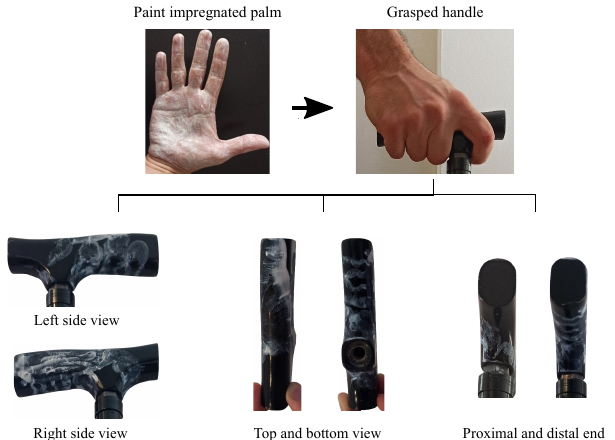
Figure 1. After covering their palm with hand paint, the volunteers grasped the handle. The painted surface helped locate the FSR sensors in an optimal